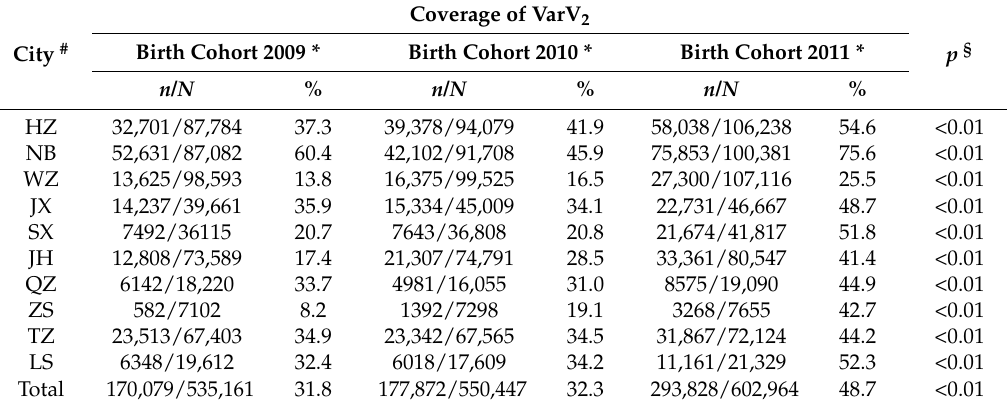
Table 2. Vaccination coverage of VarV2 of children aged 4–6 years in Zhejiang province, by